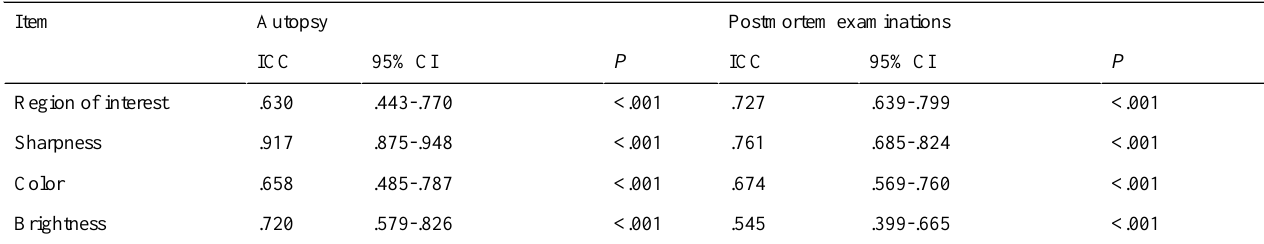
Table 6. The intraclass correlation coefficients (ICC), 95% confidence intervals (95% CI), and levels of significance ( P ) for items rated by 6 raters for autopsy and postmortem examinations, ICC(3,1), 2-way mixed, average measure.